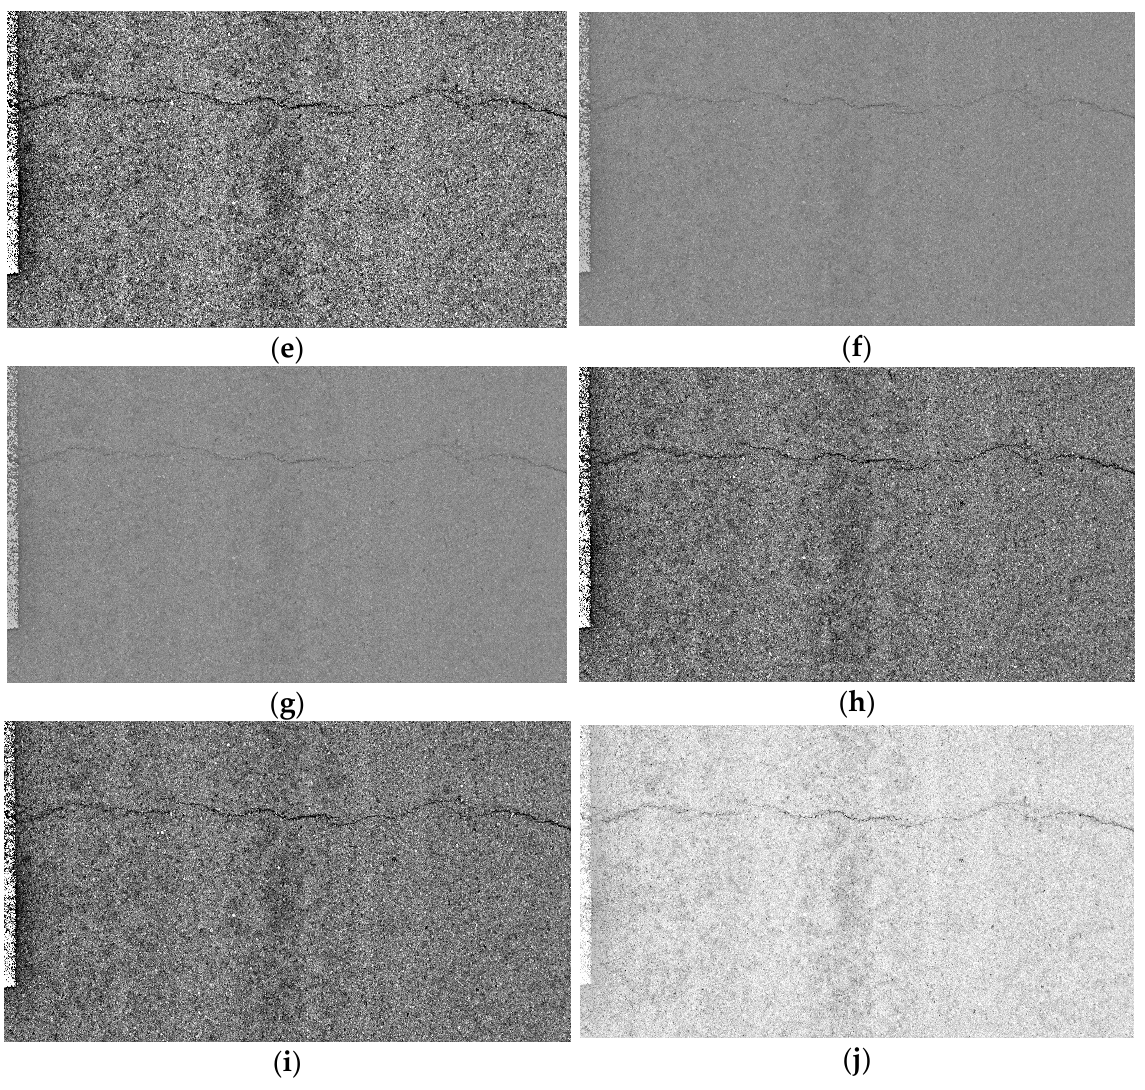
Figure 4. The results of various algorithms for crack disease image processing. ( a ) Original image, ( b ) SSR, ( c ) AutoMSRCR, ( d ) OpenCV, ( e ) MATLAB, ( f ) Gimp, ( g ) MSR, ( h ) MSRCP, ( i ) MSRCR, ( j ) method proposed in this paper. Table 1. Information entropy of crack defect images processed by various